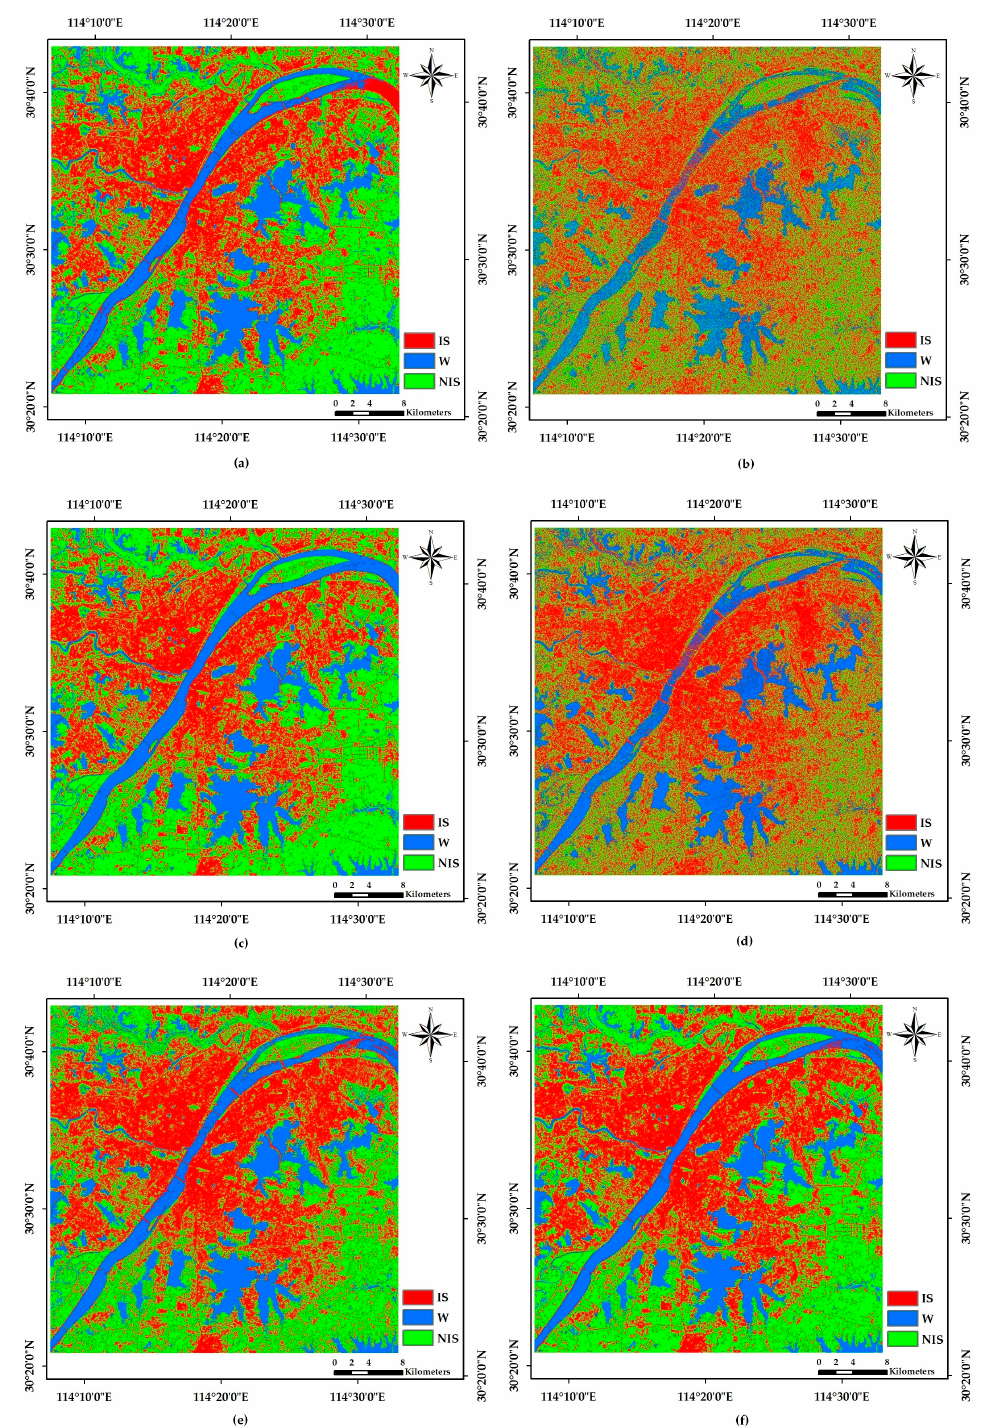
Figure 11. Impervious surface extracted from different data sources. ( a ) Impervious surface (IS) from the GF-1 image; ( b ) IS from the Sentinel-1A image; ( c ) IS from the combined use of GF-1 image and its spectral features; ( d ) IS from the combined use the Sentinel-1A and its textural features; ( e ) IS from the fusion of the original optical and SAR images; ( f ) IS from the fusion of the original optical and SAR images and their features.